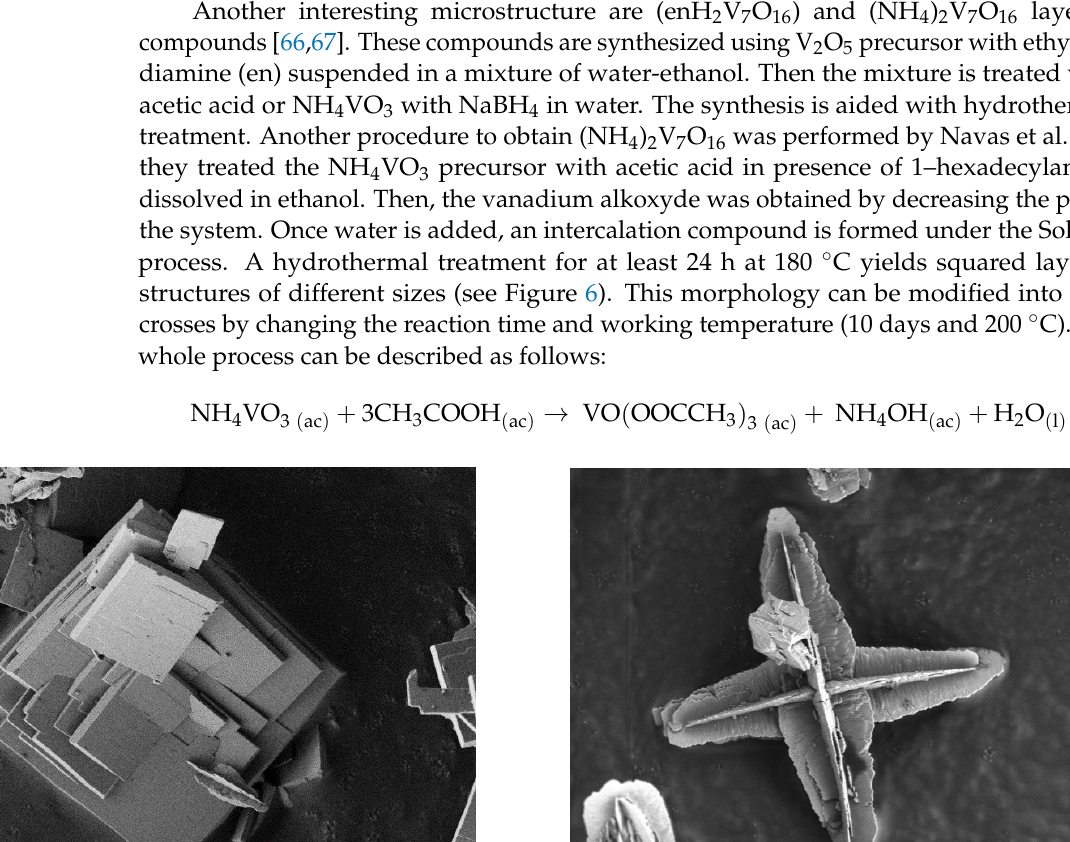
4 ) 2 V 7 O 16 microsquares, and ( b ) Isolated VO 2 cross. + H ↔ VO ( OH )( OOCCH 2 O ( l ) 3 ( ac )